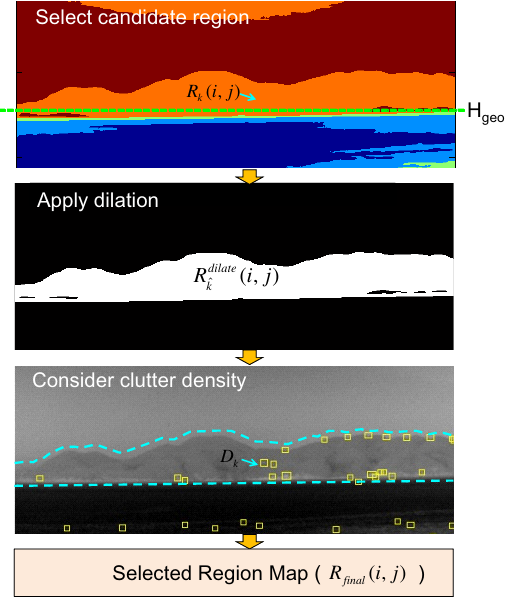
Figure 19. Region map selection flow using the geometric horizon and clutter